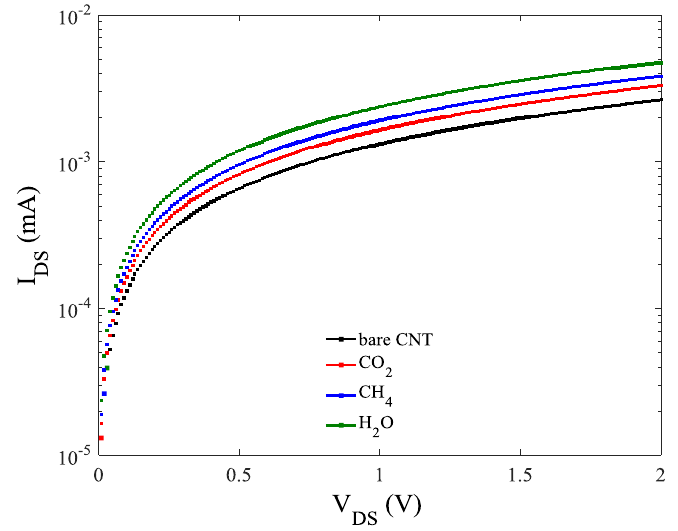
Figure 6. I-V characteristics of the gas sensor against different gas molecules.